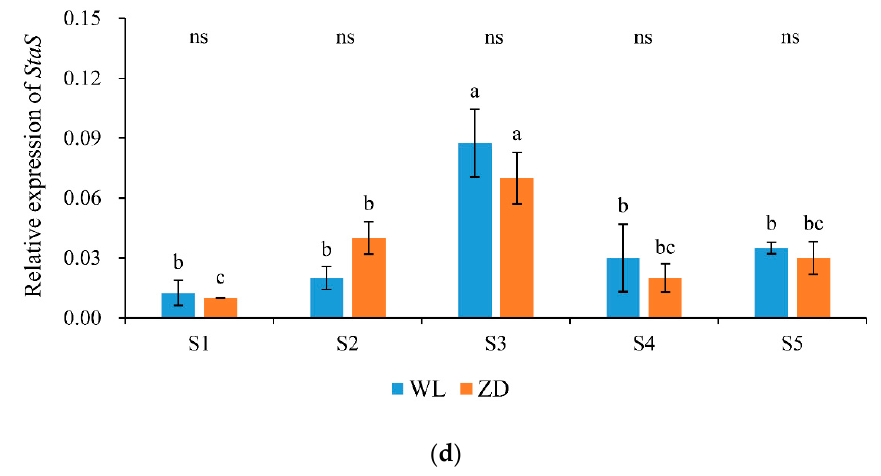
Figure 5. Relative expression levels of genes involved in carbohydrate metabolism at five sampling points. Mean values ( n = 4) ± standard errors of the mean are shown. Different letters (a, b, etc.) above bars indicate a significant difference among the five sampling points (from S1 to S5) in one cultivar ( p < 0.05). The asterisk indicates a significant difference between the cultivars (S1 vs. S1, S2 vs. S2, etc.) at one same sampling point ( p < 0.05), and the ‘ns’ indicates no significant difference. S1 to S5 are the sampling points after the five phases of the temperature-controlled treatment regime: in phase 1 the temperature was maintained at 18 °C, in phase 2 it decreased to 2 °C, in phase 3 it was maintained at 2 °C and − 2 °C for two weeks, in phase 4 it increased to 18 °C, and in phase 5 it decreased to 2 °C. ( a ) β -am = β -amylase ; ( b ) SPS = Sucrose phosphate synthase; ( c ) GaS = Galactinol synthase; and ( d ) StaS = Stachyose synthase. WL = WL440HQ, ZD = ZhaoDong.